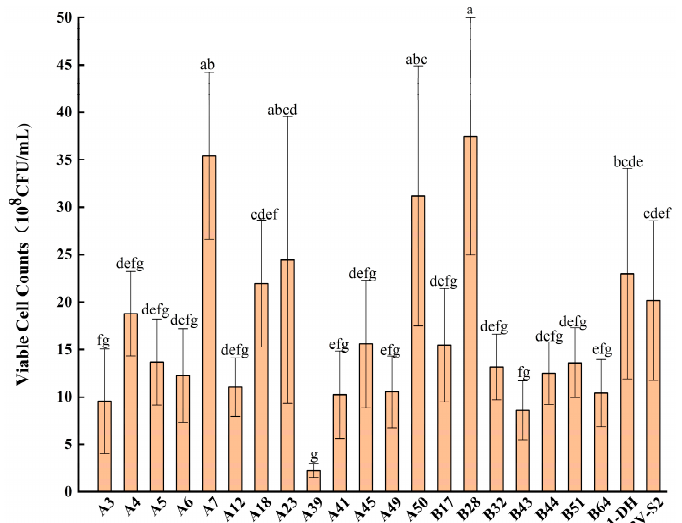
Figure 5. Growth of twenty L. plantarum and control strains in MRS-AJ, which contained pH, ethanol, and SO 2.